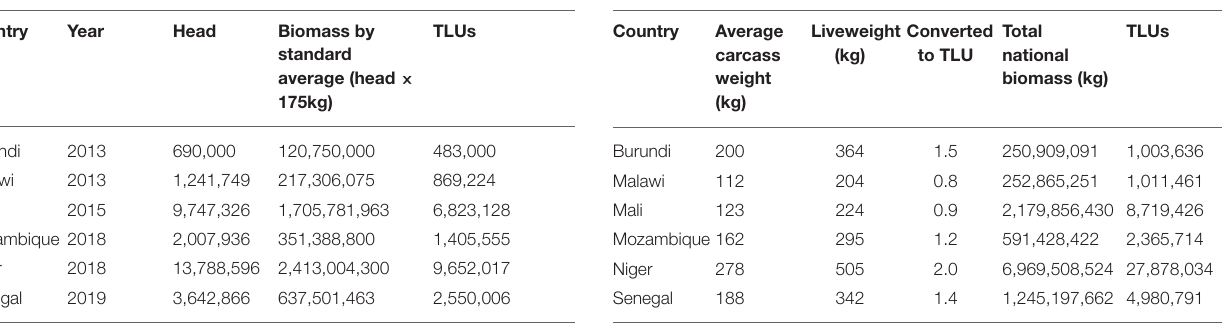
TABLE 2 | Total biomass derived through conversion of all average carcass weights to liveweights using a standard dressing percentage of 55%.